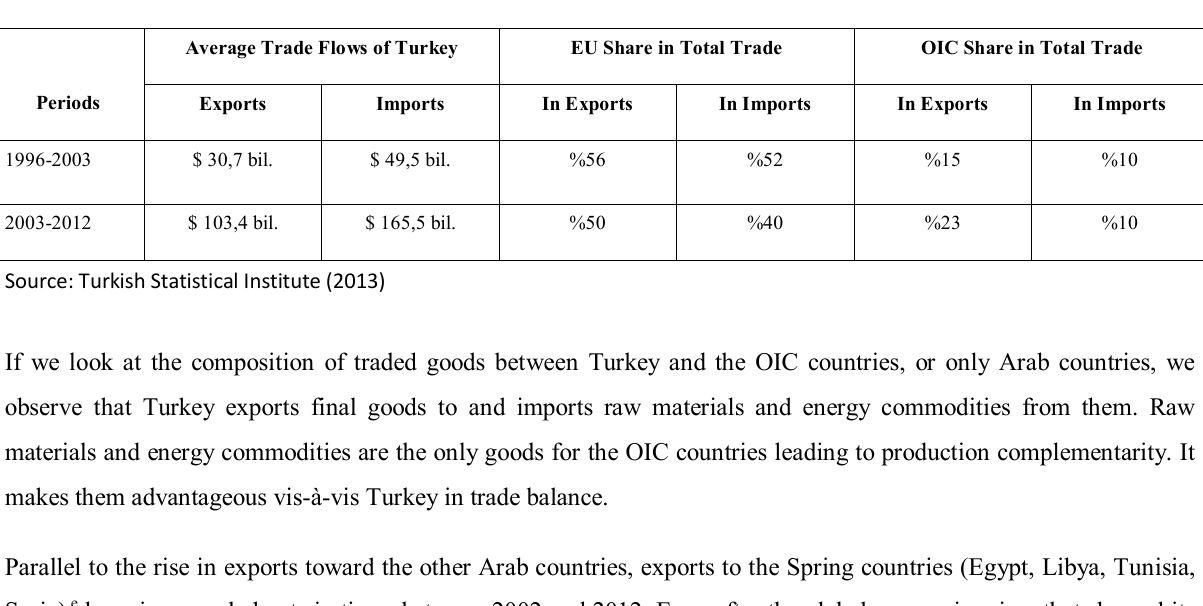
Table 1: Trade Orientation of